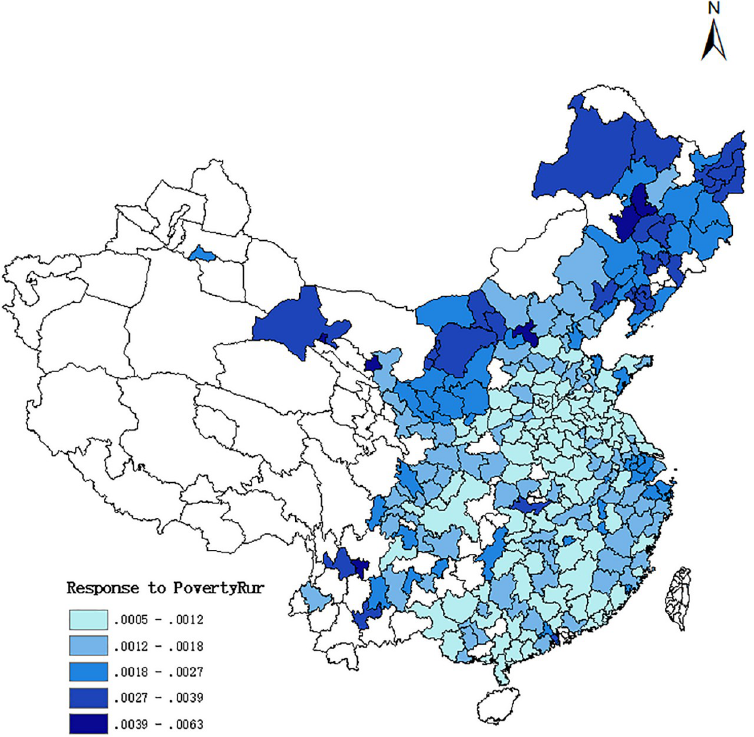
Fig 2. Response of homicide rate to a one-std.dev. Increase in Rural